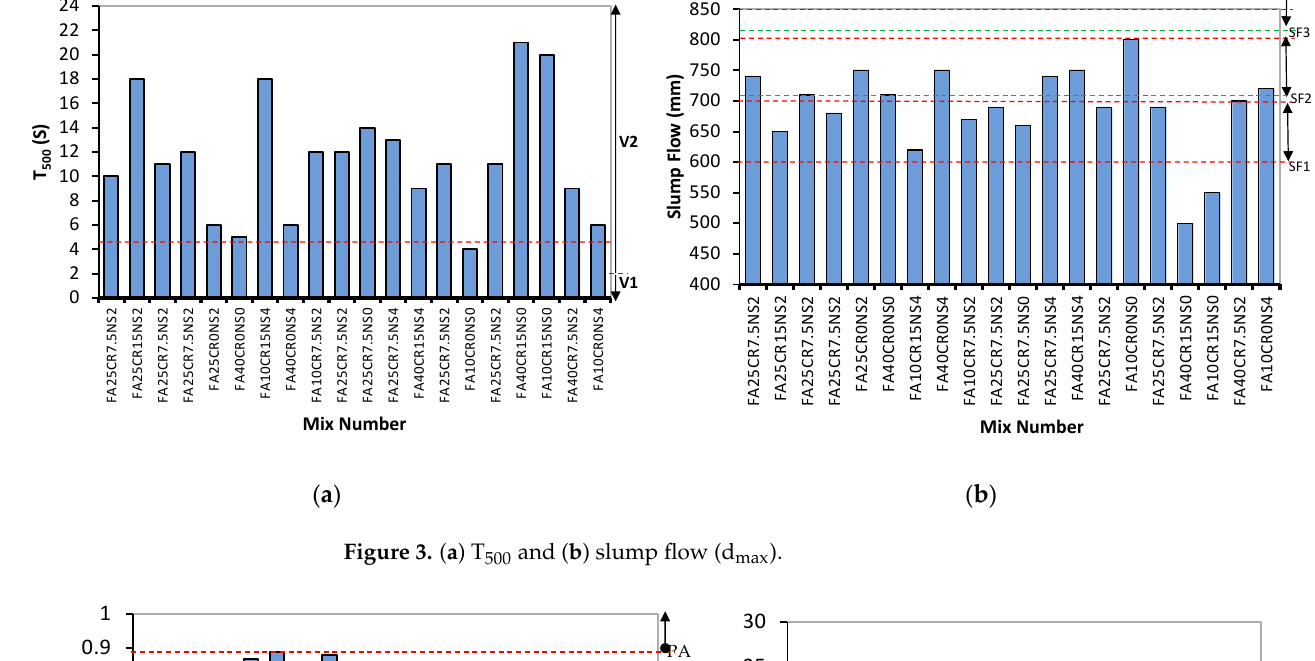
Figure 3. ( a ) T 500 and ( b ) slump flow (d max ).